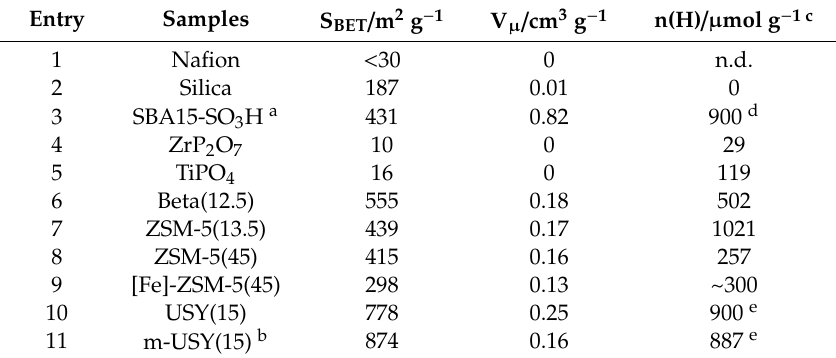
Table 1. Characteristics of tested